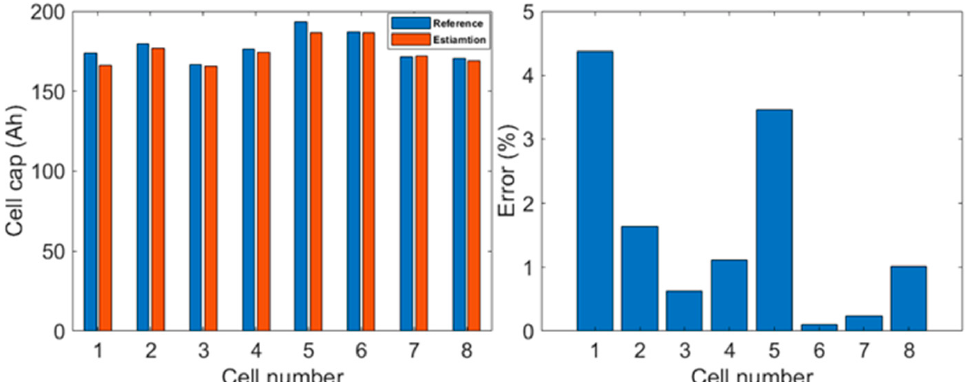
Figure 17. Estimation results and estimation error with mechanism-based method (interface data).